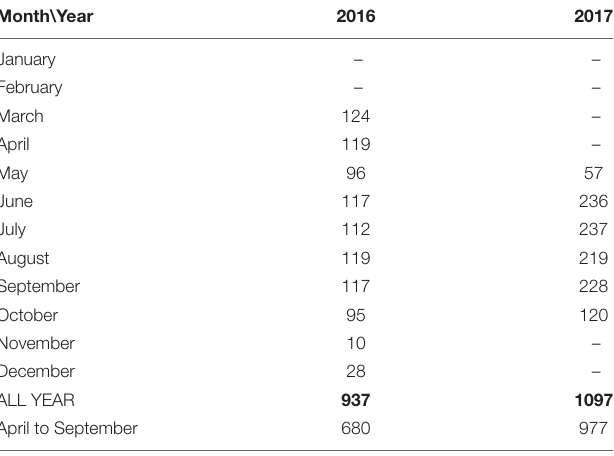
TABLE 1 | The number of available quality checked profiles from the Keri autonomous